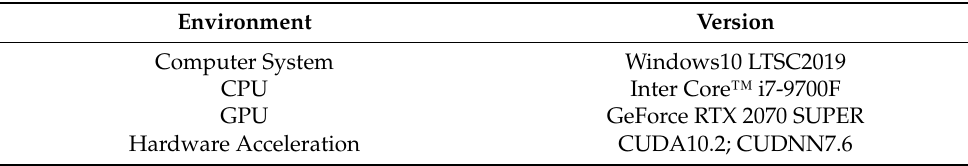
Table 1. Experimental environment configuration.